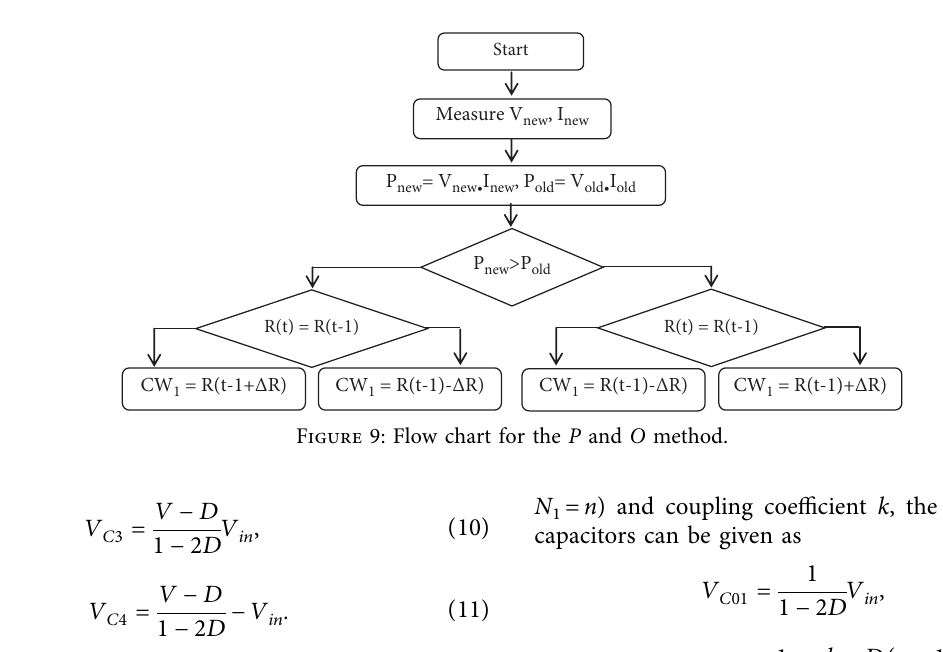
Figure 8: Model of the P and O block in MATLAB/Simulink.